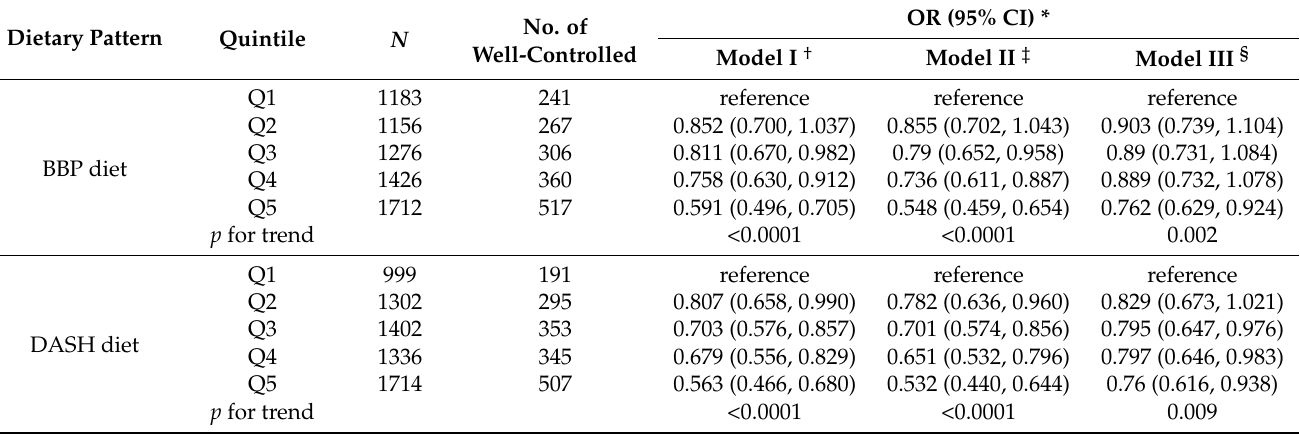
Table 3. Association between dietary pattern scores and well-controlled hypertension in the partic- ipants.